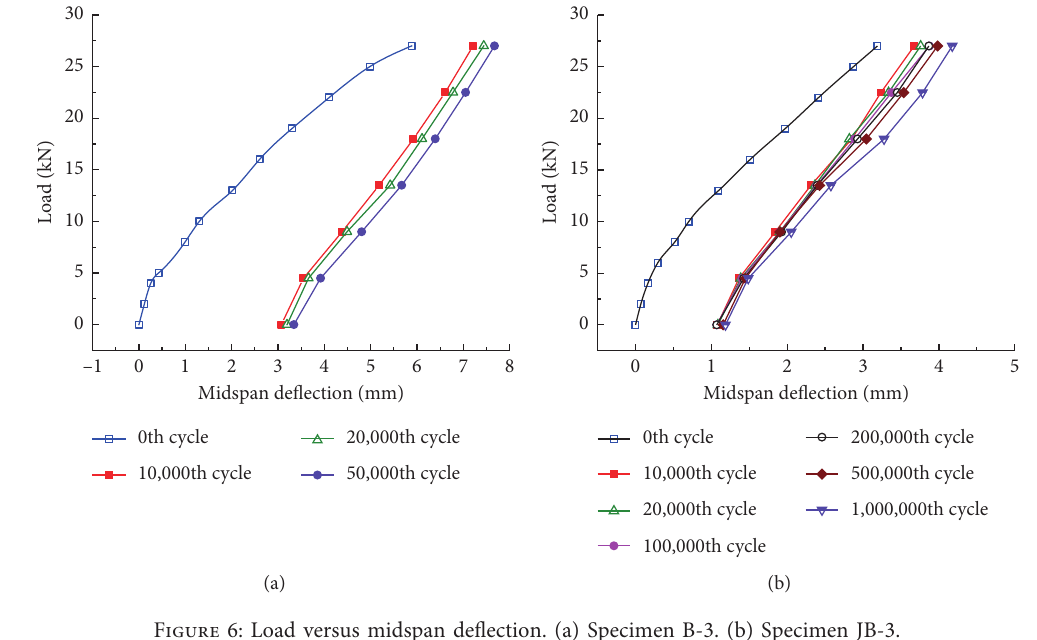
Figure 6: Load versus midspan deflection. (a) Specimen B-3. (b) Specimen JB-3.